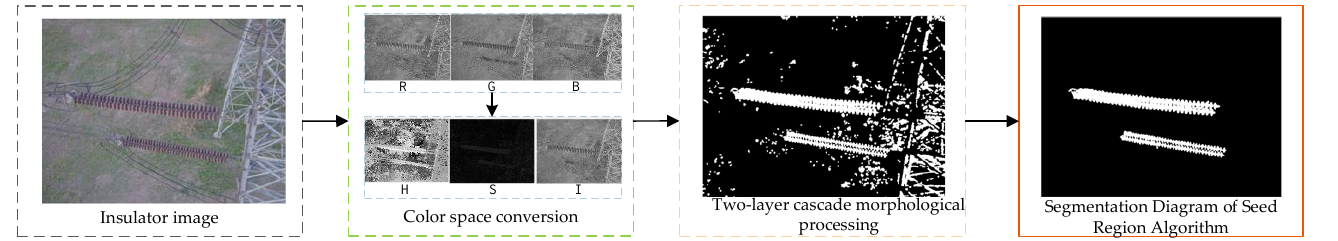
Figure 3. Region segmentation algorithm based on morphological improvements.